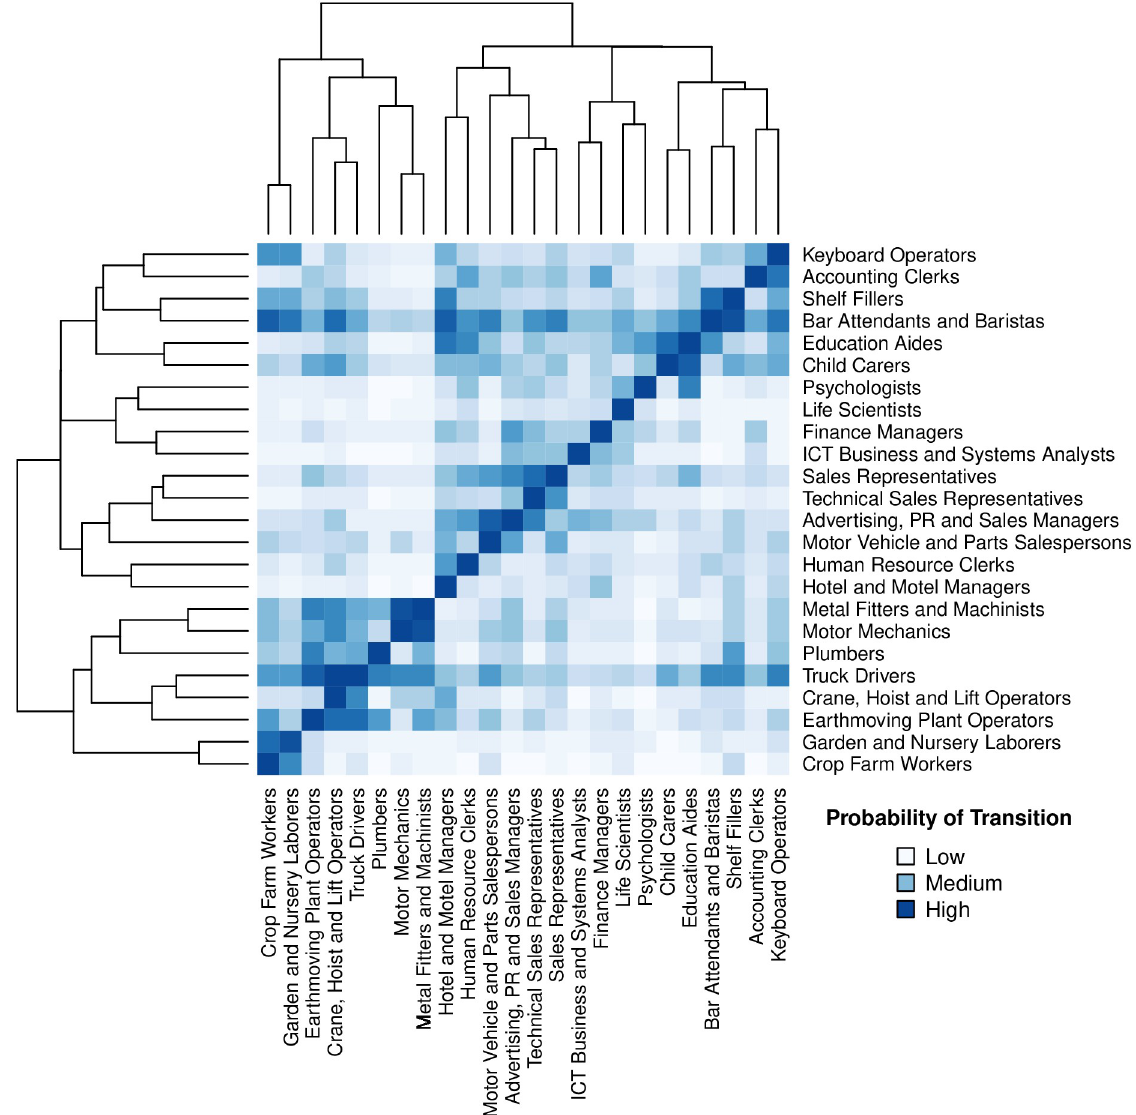
Fig 3. Validation and the Transitions Map . Visualizes a subset of the Transitions Map , where 20 occupations and their pairwise transition probabilities can be observed. In this visualization, transitions occur from columns to rows, and dark blue depicts high transition probabilities, and white depicts low probabilities. While job transitions to the same occupation yield the highest probabilities (dark blue diagonal squares), it is clear that transitions are asymmetric. The dendrogram highlights how similar occupations cluster together, where there is a clear divide between services and manual labor